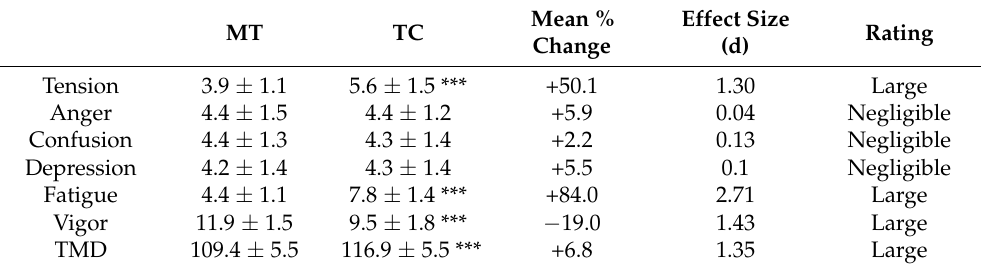
measures except TQR, a higher score is negatively associated with well-being. Table 5. The profile of mood states (POMS) subscale scores for the weeks of moderate training (MT) and intensive training camp (TC) (values are Mean ± SD; n =